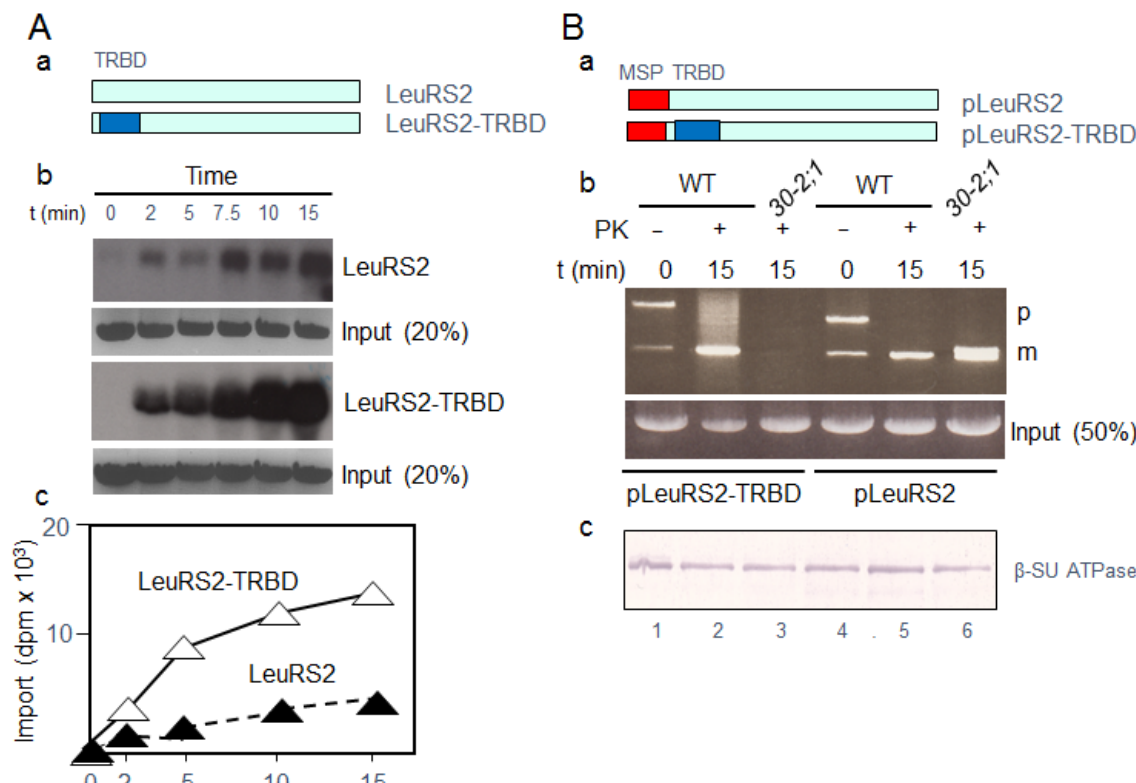
Figure 4. Mitochondrial import of LeuRS2 and engineered versions of LeuRS2 containing the mitochondrial presequence (MSP) of pLeuRS1 (pLeuRS2) and the tRNA binding domain (TRBD) of yeast pValRS1. ( A ), Structure of LeuRS2 and LeuRS2-TRBD ( a ) and import into mitochondria of wild-type plants ( b , c ). In Panel b, respectively, 20% import standards are included for LeuRS2 and LeuRS2-TRBD. ( B ), Structure of engineered pLeuRS2 containing or lacking the TRBD ( a ) and import into mitochondria of wild-type (WT) and Athp30-2;1 plants ( b ). In Panel b, a respective, 50% import standard is shown for each lane. PK, proteinase K. Panel c shows a replicate gel blot traced with an antibody against the β -subunit of the mitochondrial CF 0 /CF 1 - ATPase (β -SU ATPase).